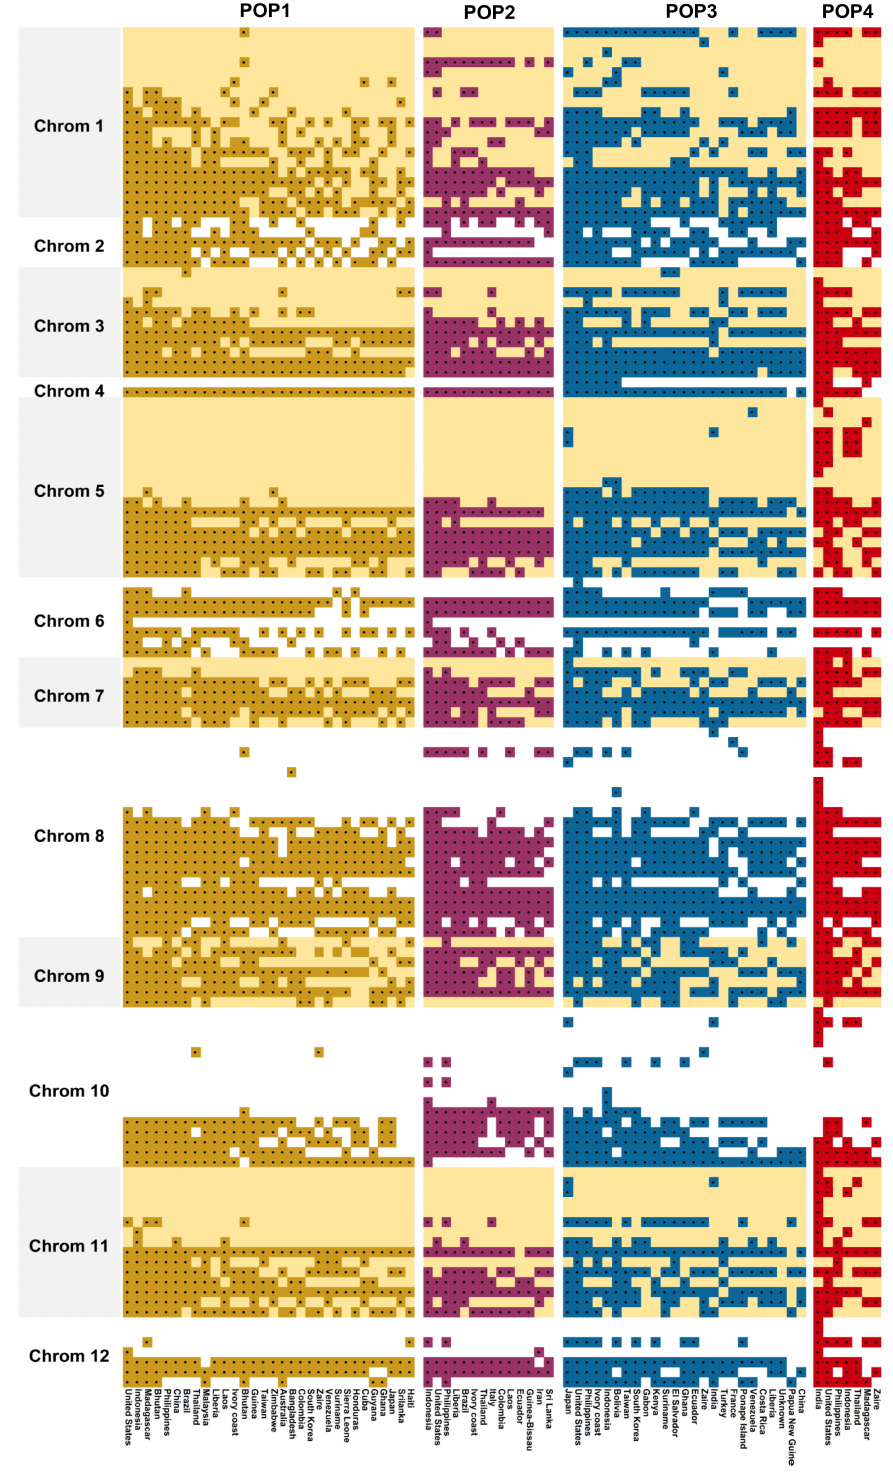
Figure 7. Chromosome-wise allele distribution among the genotypes of four subpopulations sourced from different